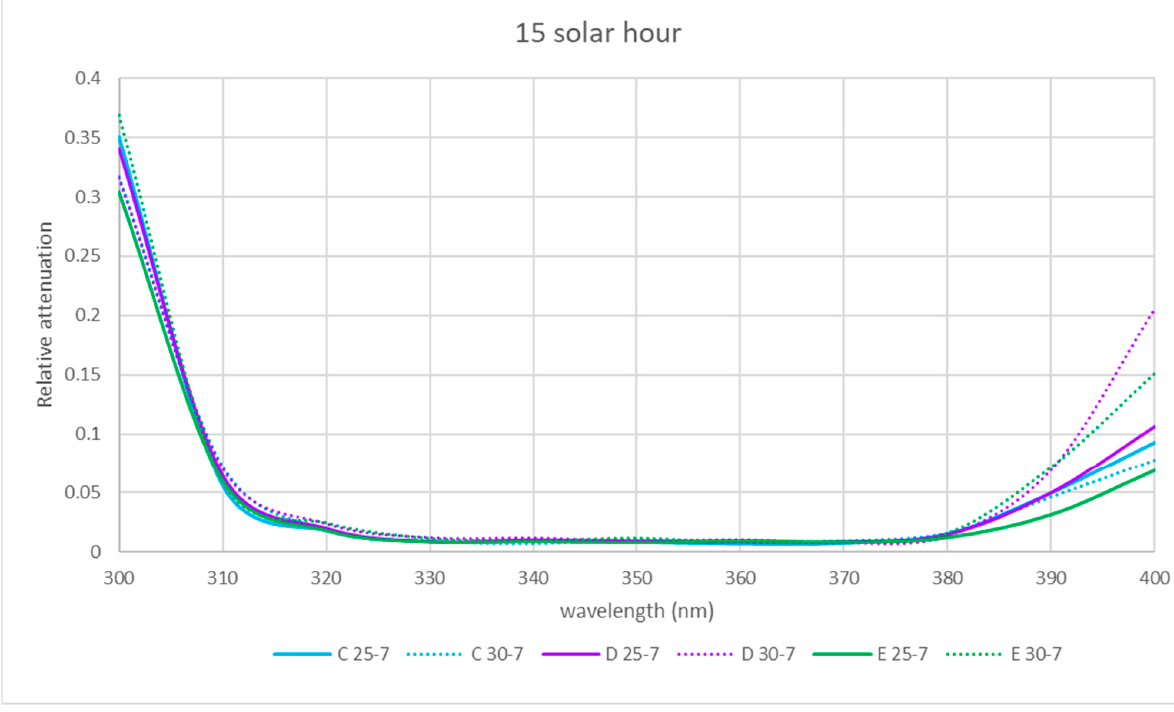
Figure 17. Comparison of spectral relative attenuation for the UV band for the three interior locations for the two skylight states (25-7 without water and 30-7 with water) at 15 solar hours. Table 9. Values of the spectral relative attenuations for the UV band for the three interior locations for the two skylight states (25-7 without water and 30-7 with water) at 15 solar hours.